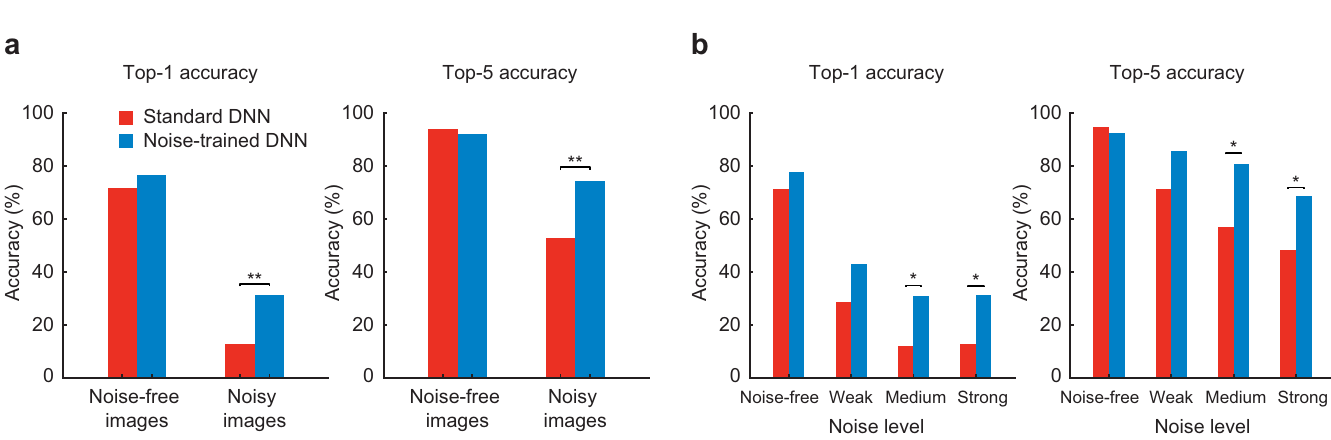
Fig 9. Noise-trained DNNs can generalize to real-world noisy conditions. (a) Top 1 and top 5 accuracies of pretrained VGG-19 (red) and noise-trained VGG-19 (blue) at classifying vehicles in noise-free or noisy weather conditions. Categories tested were convertible, jeep, minivan, motor scooter, pick-up truck, sports car, station wagon, and trailer truck. Noise-trained VGG-19 outperformed pretrained VGG-19 at recognizing noisy vehicle images (top 1 accuracy, χ 2 = 10.29, p = 0.0013; χ 2 = 10.26, p = 0.0014). (b) Top 1 and top 5 accuracies sorted by noise-level rating. Data are available at https://osf.io/bxr2v/. A statistical difference in performance was observed between models when the noise level was moderate or strong ( χ 2 > 4.5, p < 0.05 in all cases). Asterisks indicate � p < 0.05, �� p < 0.01. DNN, deep neural